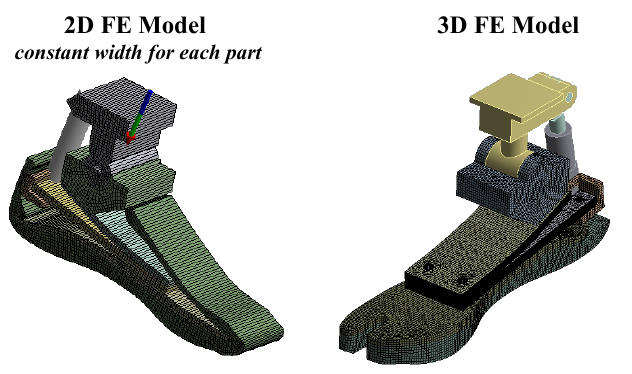
Figure 17. The width of each part in the 2D FE model was constant and the holes were not considered.